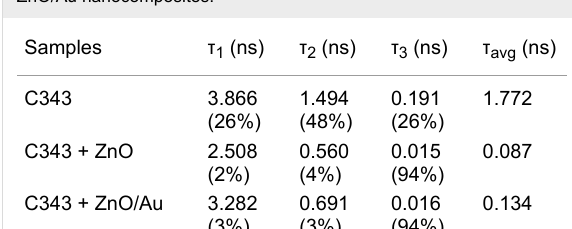
Table 3: Dynamics of picosecond-resolved luminescence transients of C343 dye in the presence and absence of bare ZnO nanorods and ZnO/Au nanocomposites.